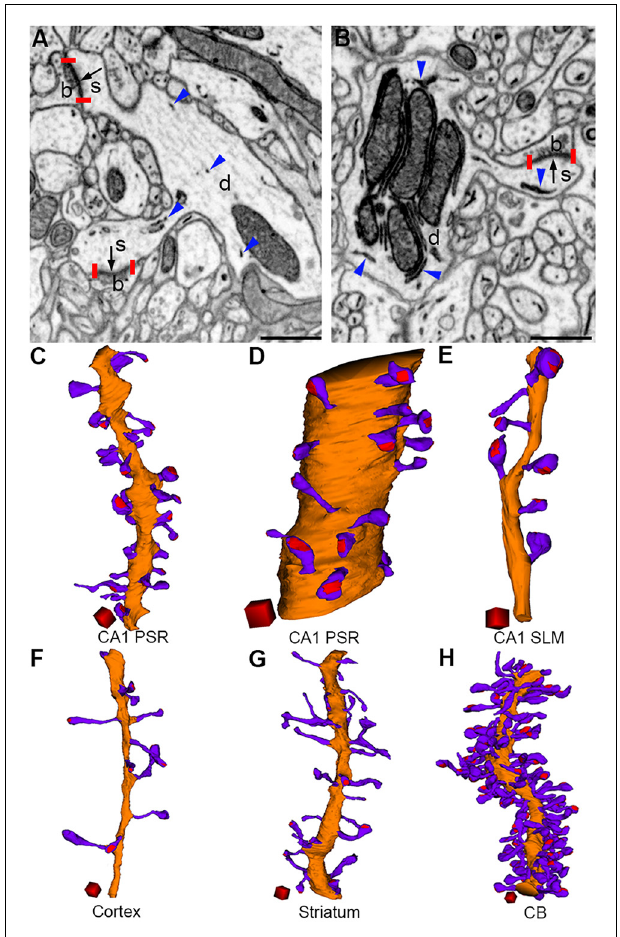
FIGURE 3 | Morphological diversity of dendritic spines in the brain (adapted from Parajuli et al., 2020a). Presynaptic boutons (b), dendrites (d), and spines (s) can be identified in FIB-SEM images from the cerebral cortex (A) and cerebellum (B) . PSDs (bordered by red vertical bars) are indicated by black arrows and ER are indicated by blue arrowheads. Three-dimensional reconstructions of dendrite (orange), spines (violet), and PSDs (red) from the CA1 proximal stratum radiatum (oblique dendrite, C ), CA1 proximal stratum radiatum (large-caliber dendrite, D ), CA1 stratum lacunosum moleculare (E) , cortex (F) , striatum (G) , and cerebellum (H) . Scale bars: 500nm (A,B) . Scale cubes: 0.5 µ m on each side (C–H)